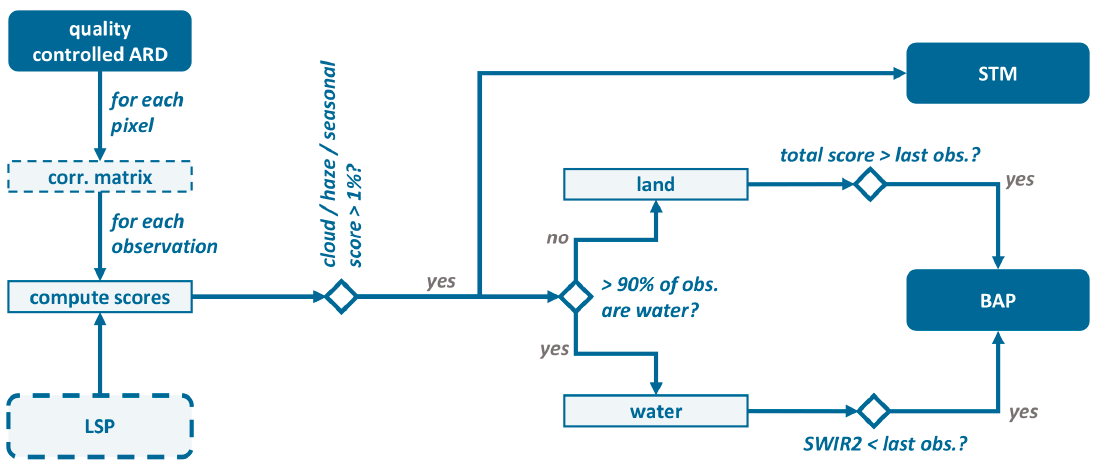
Figure 8. Processing workflow of the FORCE Level 3 Processing System (L3PS). STM—spectral temporal metric; BAP—best-available pixel composite.